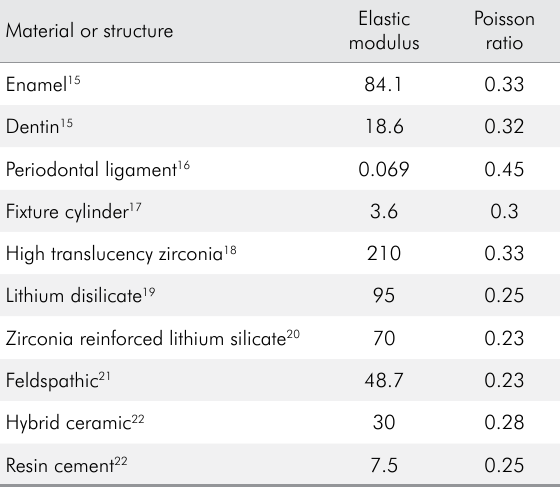
Table 2. Mechanical properties of materials and structures used in the study.